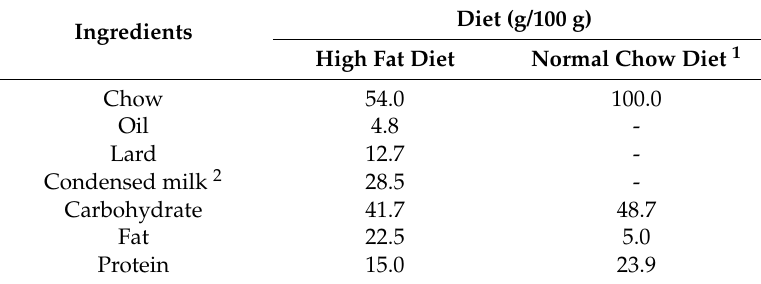
Table 6. Compositions of normal chow diet and high-fat diets.